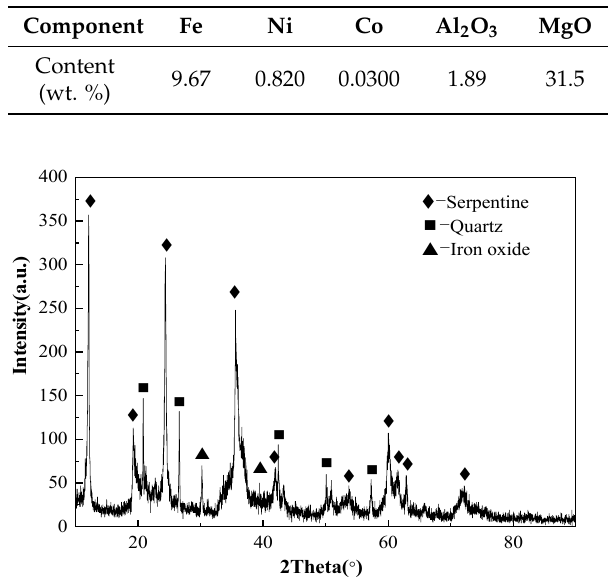
Figure 2. X-Ray Diffraction (XRD) analysis of laterite nickel ore.